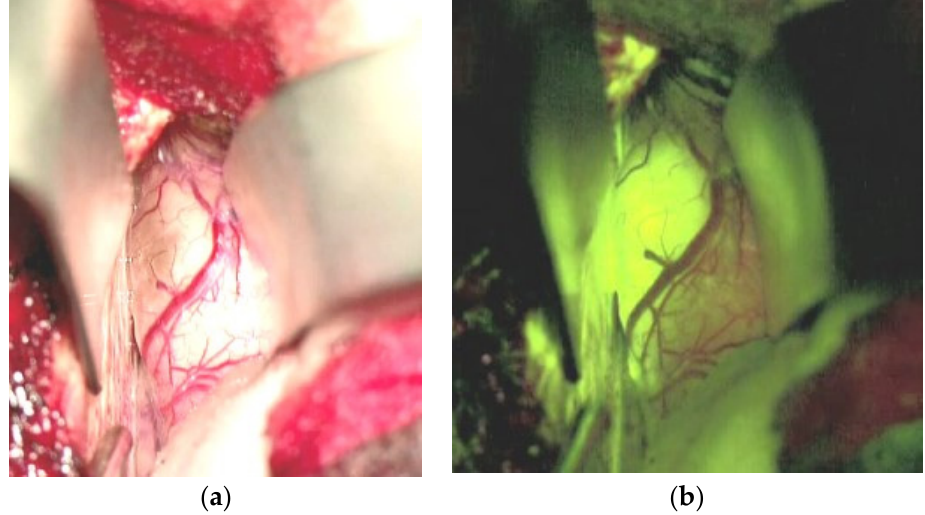
Figure 1. Renal cell cancer metastasis of the right cingulate gyrus, interhemispheric approach. ( a ): Surgical field under white light, ( b ): Surgical field under YELLOW 560 nm filter.